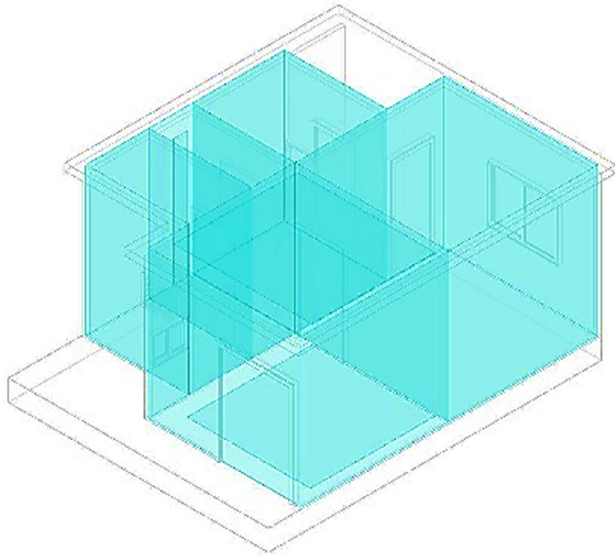
Figure 15. Energy model.